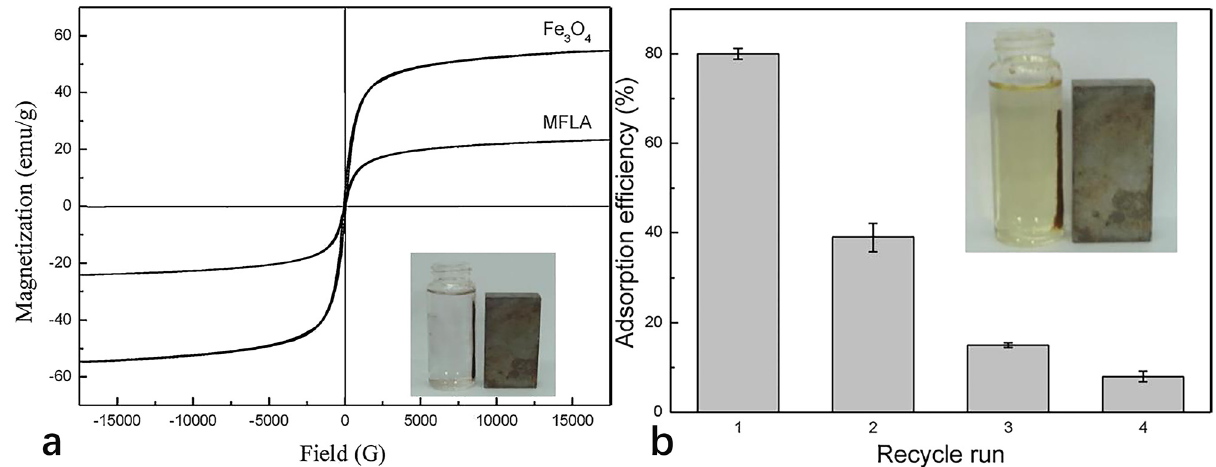
Figure 9: Magnetization characteristic curve ( a ) and the absorption e ffi ciency in recycle runs ( b ) [ 136 ] .